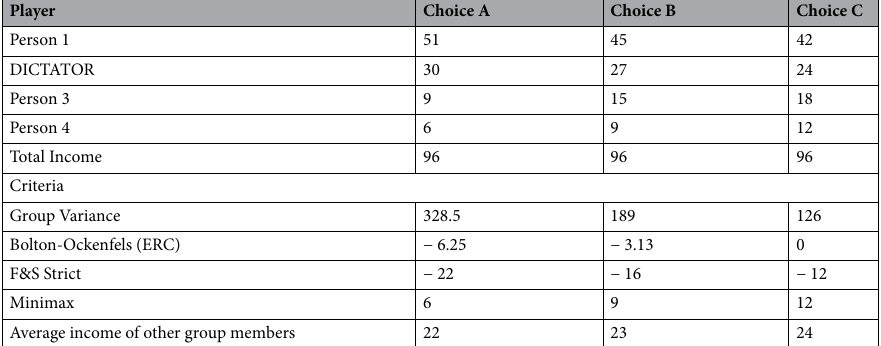
Table 2. Parameters of the distribution game (DG). Group Variance is the variance of the payoffs of each choice. Bolton & Ockenfels(ERC) is calculated as ERC = − abs (cid:31) Dictator Payoff 96 − 1 4 (cid:30) .